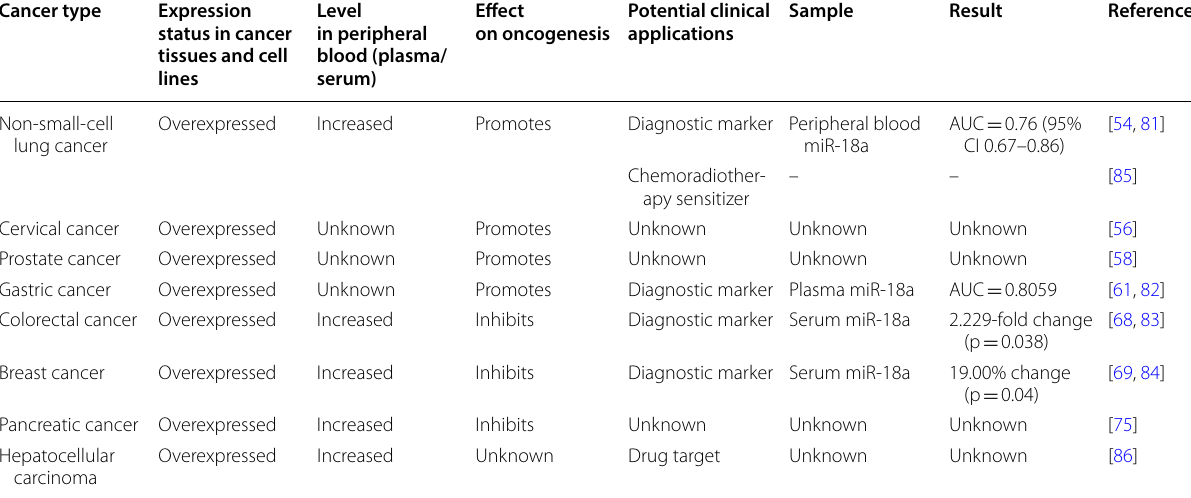
Table 2 The dual function of miR-18a in human cancers and miR-18a clinical applications Cancer